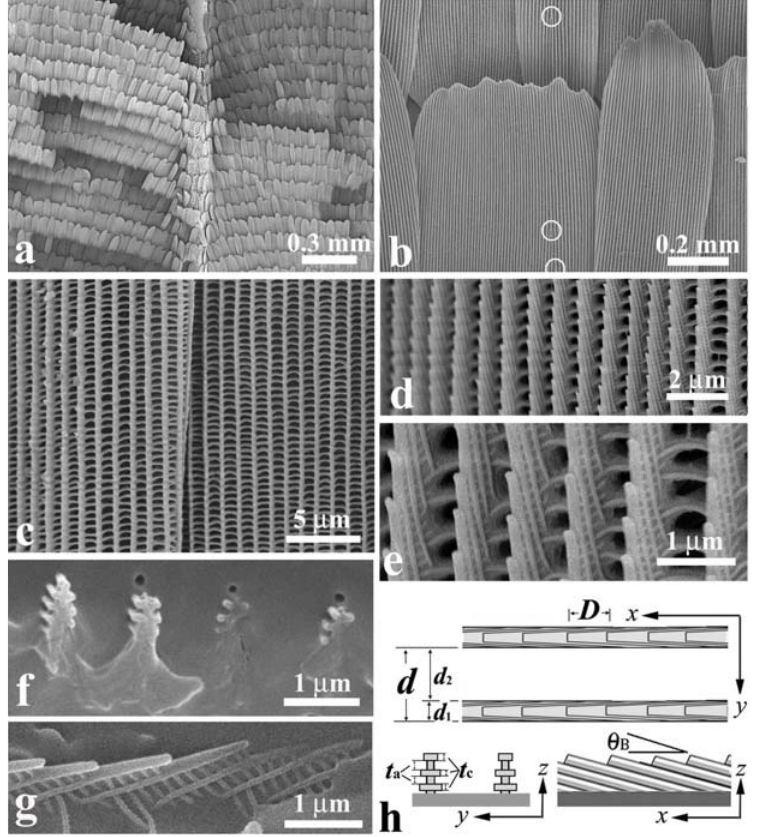
Figure 3. Scanning electron microscope (SEM) images of scales in the forewing of the male E. mulciber . ( a ) Scales on a vein and B scales in the blue-iridescent background; ( b ) B scales; ( c ) Top view of two B scales; ( d , e ) Enlarged images of ridges in the B scale; ( f ) Cross-section of ridges on a y-z plane; ( g ) Cross-section on an x–z plane; ( h ) Schematic of the piled cuticles (adapted from